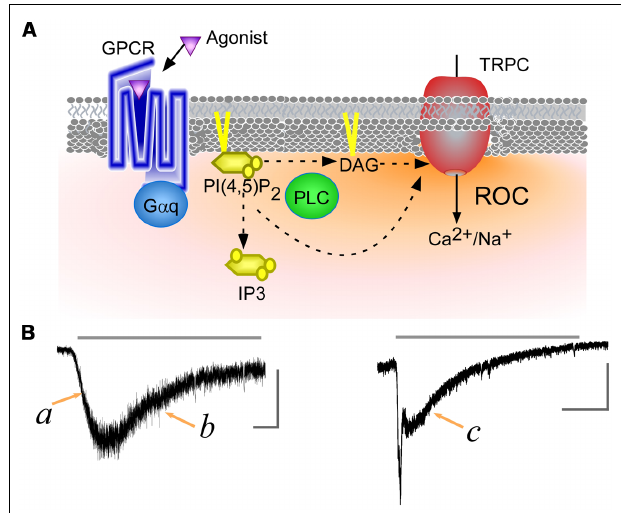
FIGURE 1 |Transient receptor potential canonical (TRPC) channels receptor-operated Ca 2 + currents (ROCs). (A) Schematic representation of ROCs. Binding of an agonist to a G q -protein-coupled receptor leads to phospholipase C (PLC) activation.The activated PLC hydrolyzes phosphatidylinositol 4,5-bisphosphate [PI(4,5)P 2 ] to produce of diacylglycerol (DAG) and IP 3 . DAG and the reduction of PI(4,5)P 2 levels directly contribute toTRPC channels activation, while IP 3 triggers Ca 2 + release from intracellular stores. (B) ROCs throughTRPC7 channels.TRPC7 currents were induced using carbachol, a muscarinic receptor agonist (gray line, 100 μ M). Left and right panels respectively display currents observed with low and high levels of muscarinic receptor expression (data from Itsuki etal., 2014).The vertical and horizontal gray scale bars indicate 200 pA and 15 s,